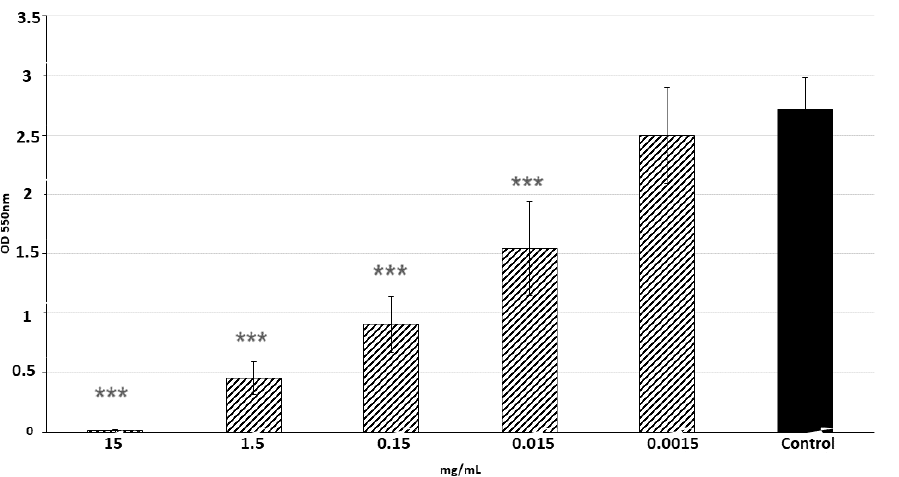
Figure 2. MALDI-TOF/MS Spectra of LPs Isolated from B. amyloliquefaciens 3/22.